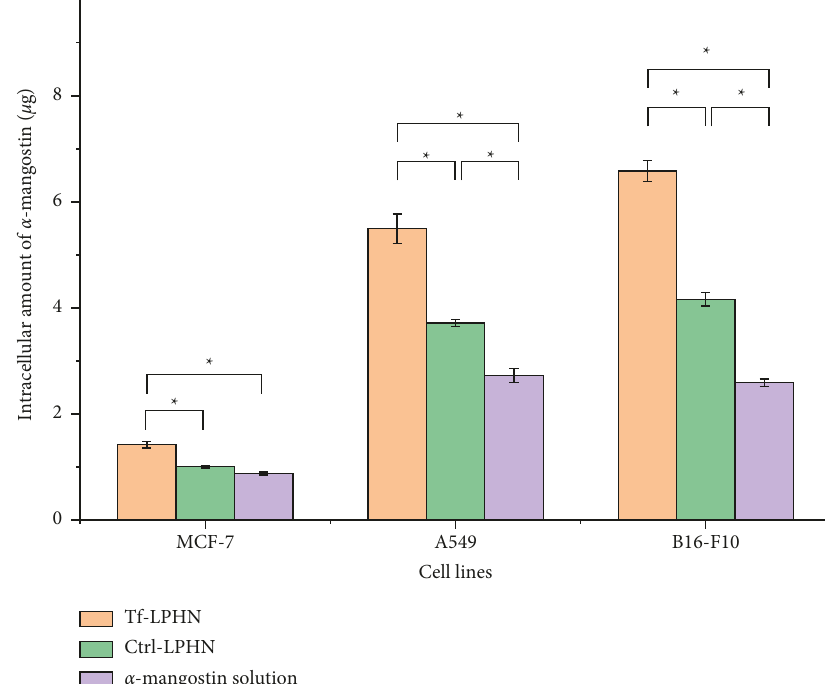
Figure 4: Cellular uptake of α -mangostin (10 µ g/well) either formulated as Tf-LPHN (orange) and Ctrl-LPHN (green) or as drug solution (purple), in MCF-7, A549, and B16–F10 cell lines ( n � 6) ( ∗ p < 0 .